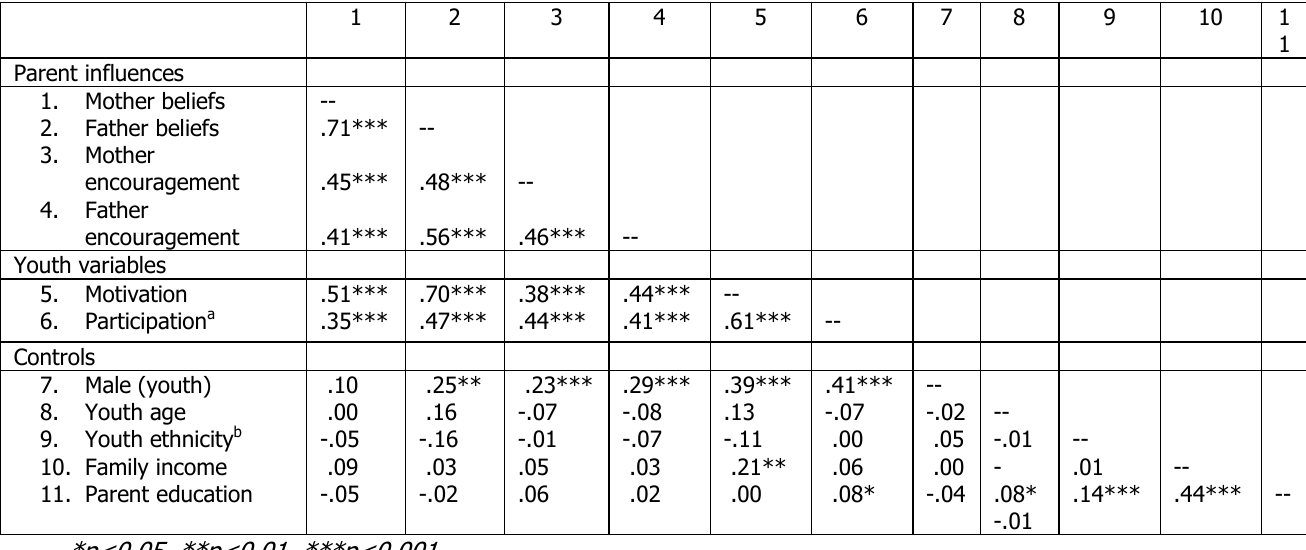
Pearson correlations among variables